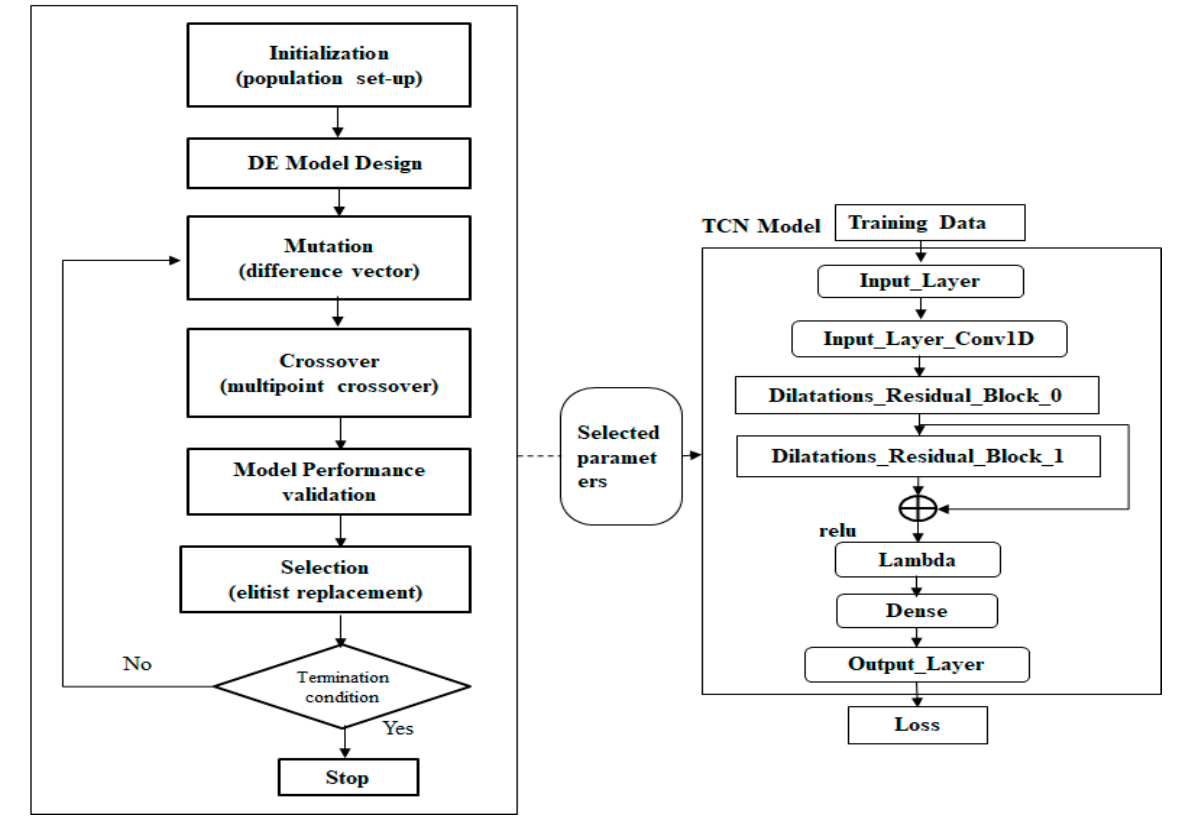
Figure 8. Differential evolution used to decide the optimal parameters of TCN model training.